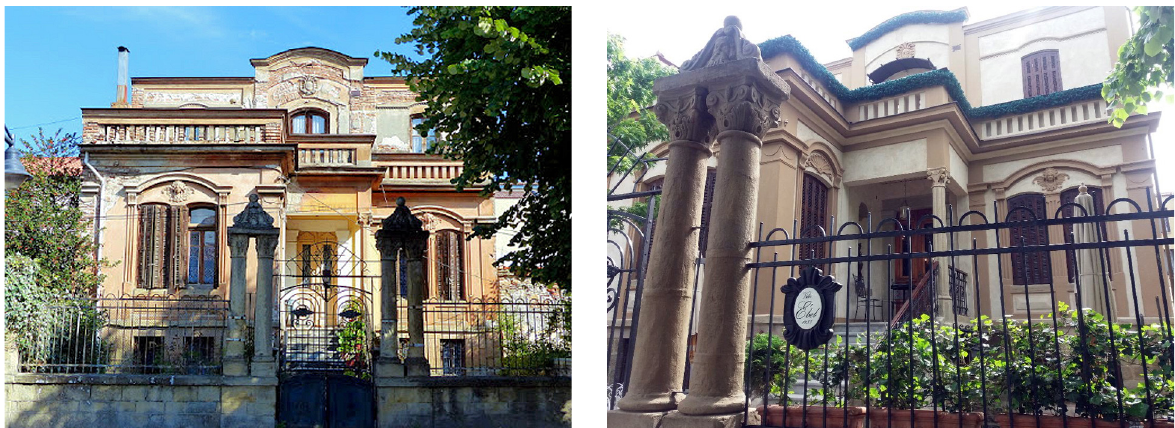
Fig. 3. A house building of 1933 before (left), actually Vila Ebel after restoration